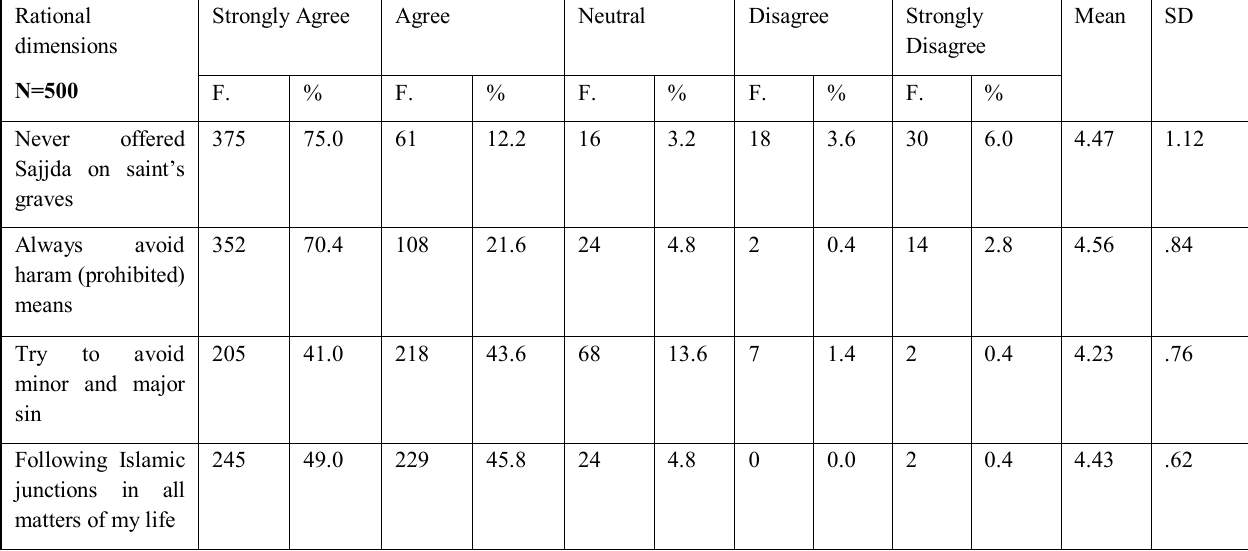
(Table III) Scale: 1 = strongly disagree, 2 = Agree, 3 = Neutral, 4 = Agree, 5 = strongly